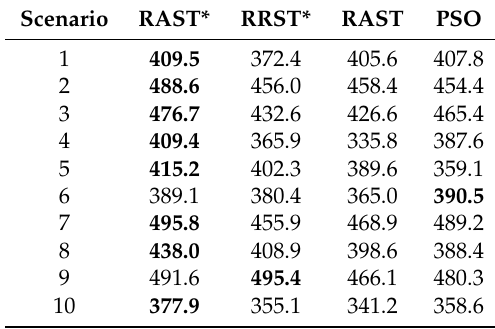
Table 5. Information gathering of RAST*, RRST*, RAST, and PSO over ten randomly selected scientific interest areas with 200 × 140 grids. The maximum information gathering for each scenario has been highlighted in